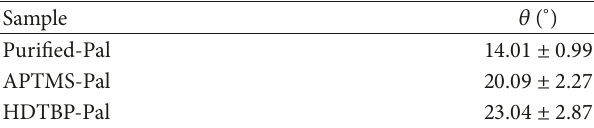
Table 1: Contact angles for ethylene glycol on three types of